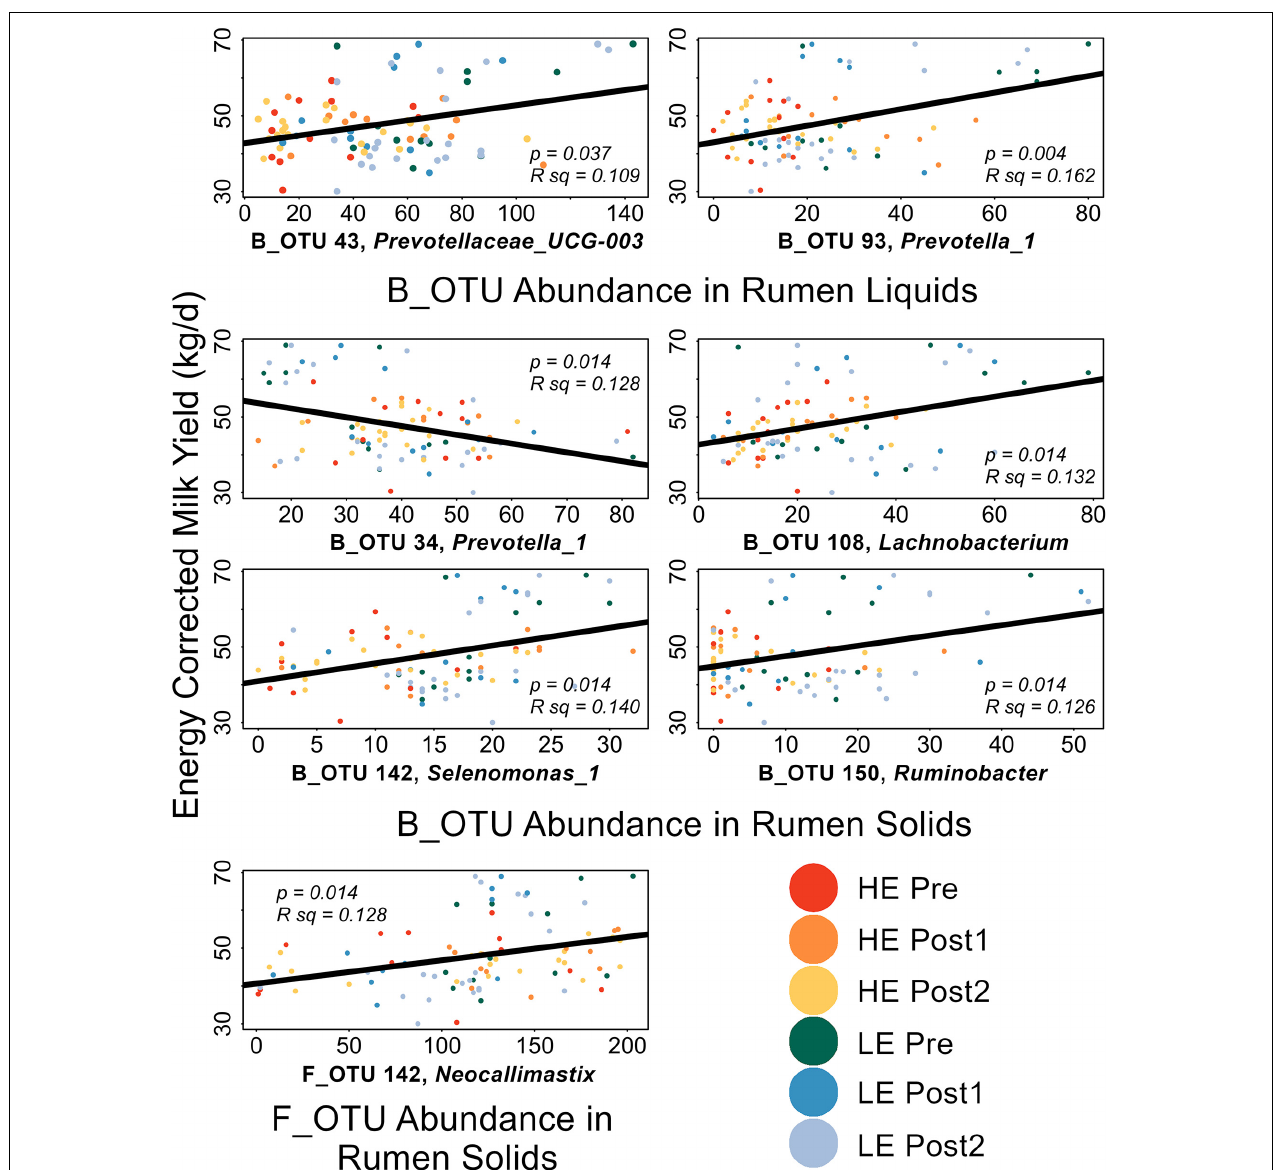
FIGURE 5 | Scatterplots of LEfSe-implicated OTUs with significant correlations to production metrics. FDR-corrected p -values and the R 2 values for the linear mode (black) are expressed on each plot. Points are color coded by initial efficiency of host and time within trial. Genus-level classification of the OTUs are as